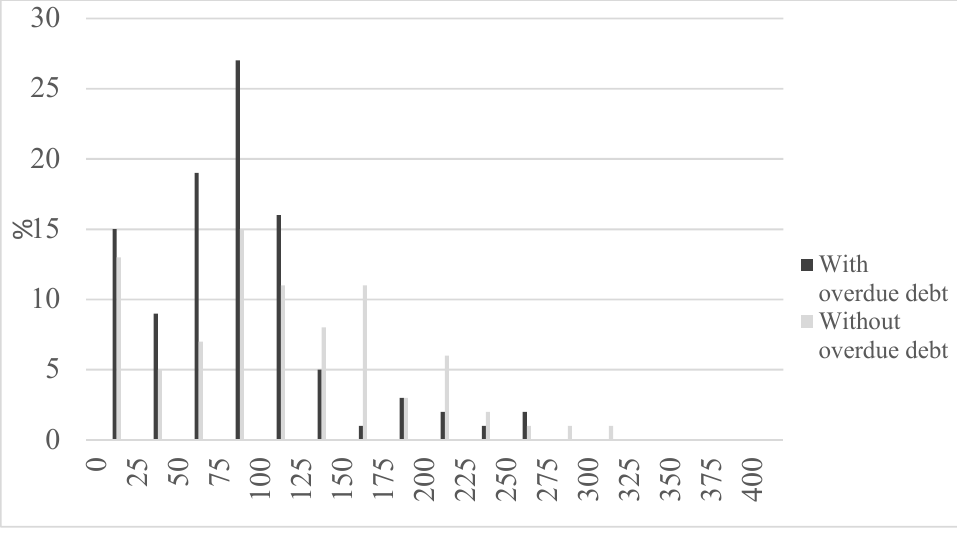
Figure 2. Distributions of net income in the subsamples of individuals with and without overdue debts. Source: Questionnaire-based survey, small settlements of BAZ County, Hungary, 2019.